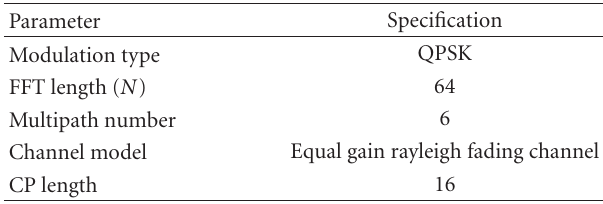
Table 1: System simulated parameters.